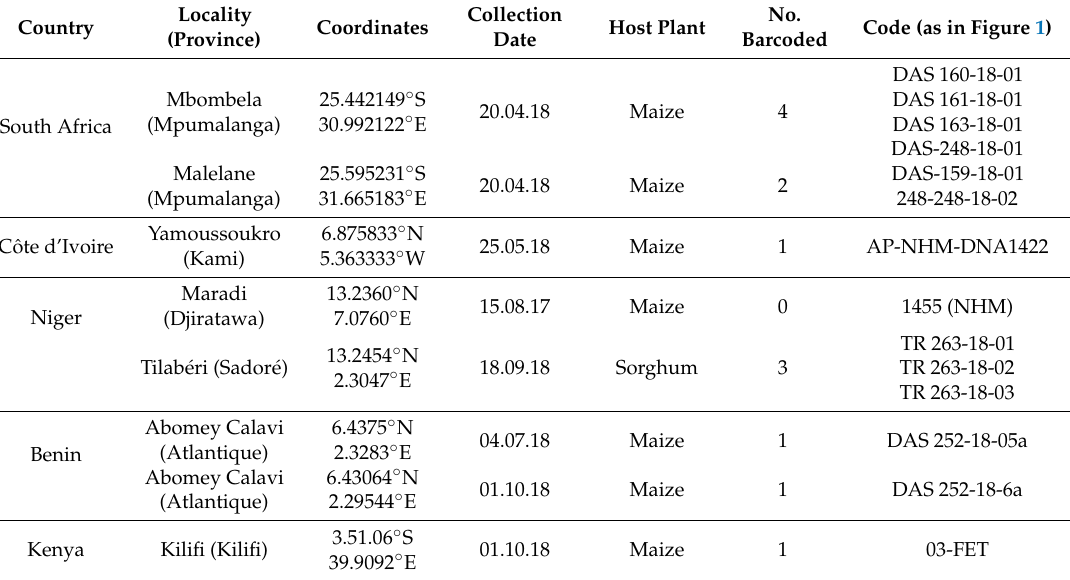
Table 1. Details of the sampling sites, numbers, and accession numbers of specimens